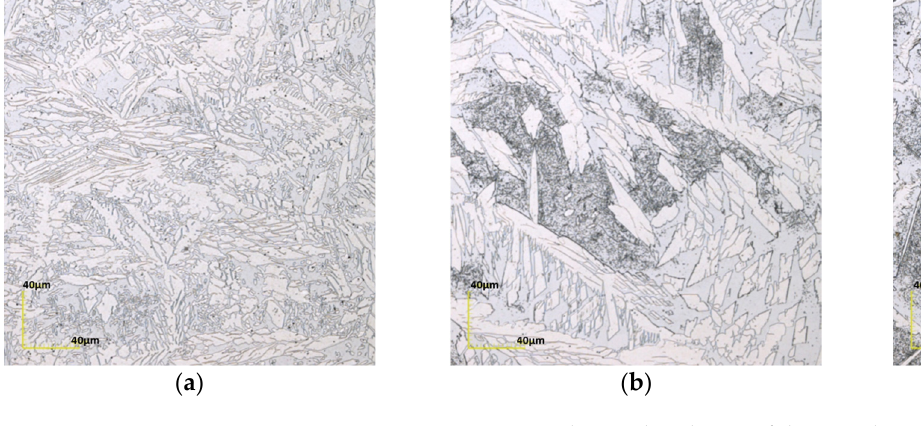
( c ) Figure 9. Microstructure observed in the HAZ of the sample subjected to postwelding solution heat treatment for 10 s at 1050 °C: ( a ) edge; ( b ) 1/4 region; ( c ) 1/2 region. In the FZ, the edge region showed high austenite content and microstructure with no nitrides. However, the 1/4 and 1/2 regions showed a high fraction of chromium nitrides in a greater amount than in the welded condition, with ferrite and austenite contents ap- parently close to equilibrium. In the HAZ, the absence of nitrides was also observed in the edge region, but with a proportion of ferrite to austenite close to equilibrium. The 1/4 and 1/2 regions showed high volumetric fractions of chromium nitrides in a considerably higher amount than in the welded condition. Furthermore, in these regions, the ferrite content was considerably higher. The presence of chromium nitrides in the microstructure, even after postwelding heat treatment, could be attributed to the low temperature of the solubilization combined with insufficient retention time for the dissolution of these precipitates [26]. 3.2.3. Solution Heat Treatment for 10 s at 1150 °C The microstructure observed in the FZ and HAZ of the sample treated at 1150 °C for 10 s is shown in Figures 10 and 11, respectively.